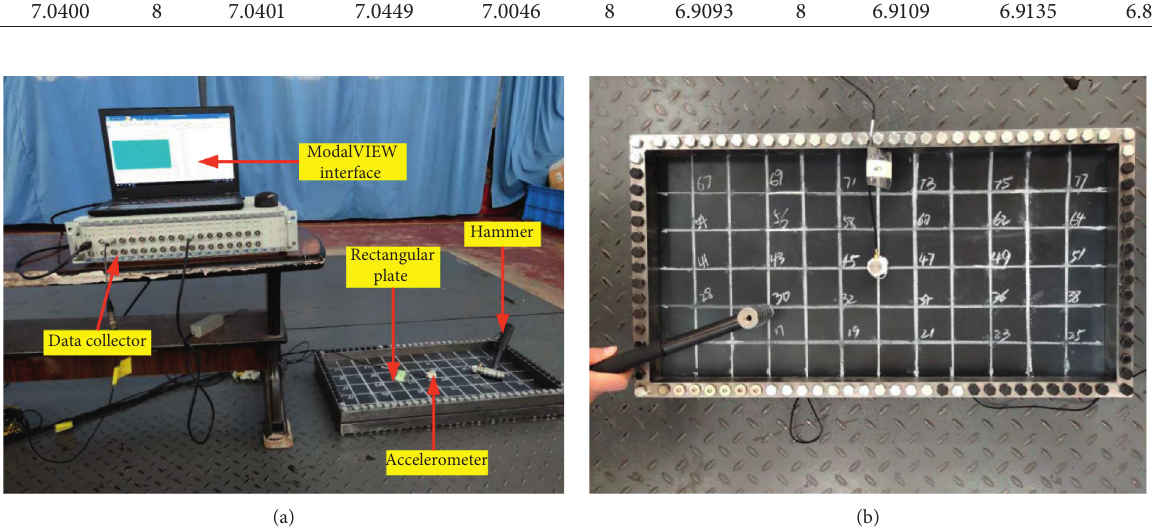
Figure 3: The experimental setting for a rectangular plate. (a) Experimental plate. (b) Single vibration